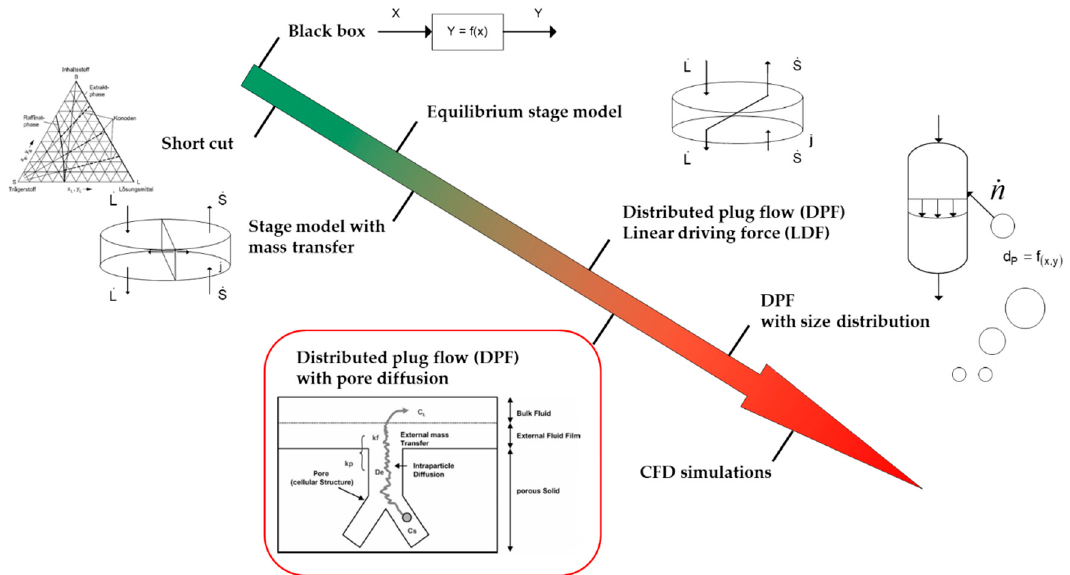
Figure 1. Overview of different modeling depths with increasing detail [18].